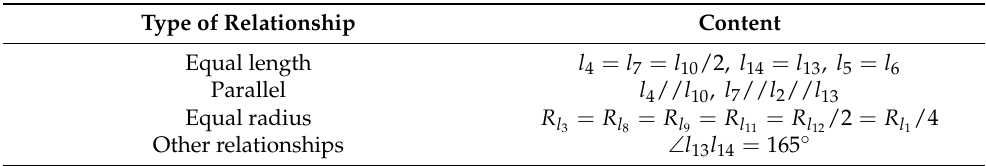
Table 1. Relationships between the graphic elements.